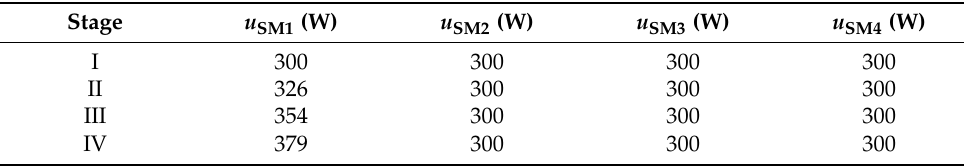
Table 5. Corresponding sub-module voltage